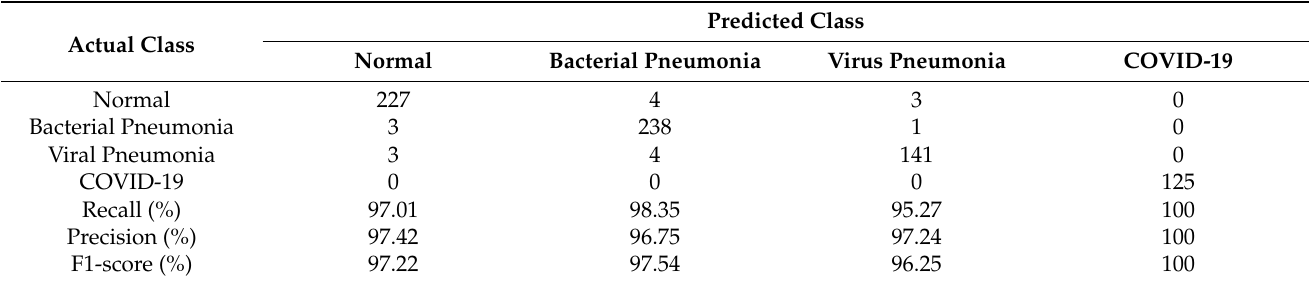
Table 3. Results obtained using our proposed Exemplar COVID-19FclNet9 model with DB1 database.